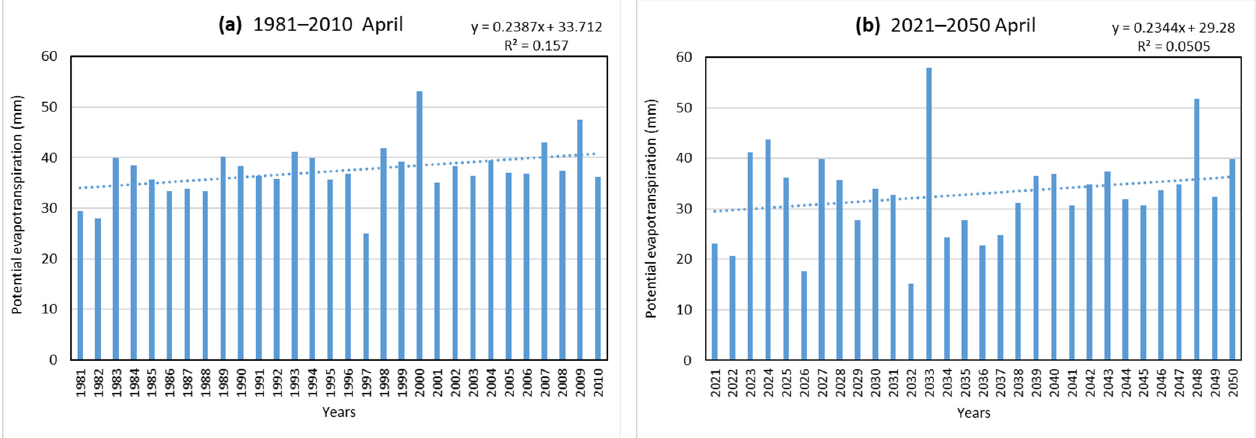
Figure 3. Time trend of sweet cherries’ potential evapotranspiration in the vegetation period (April– September) in the reference ( a ) and forecast period ( b ). The trend line is marked with a dashed line.